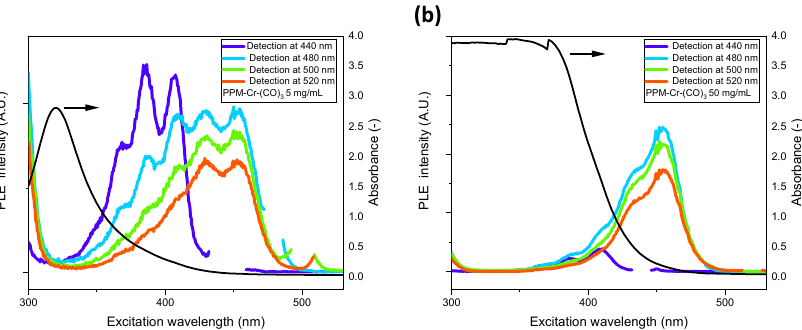
Figure 11. PLE spectra of PPM-Cr(CO) 3 (0.055 Cr per phenylene group) in chloroform for emissions detected at 440 nm (dark blue curve), 480 nm (light blue curve), 500 nm (green curve) and 520 nm (red curve): ( a ) 5 mg/mL concentration; ( b ) 50 mg/mL concentration.